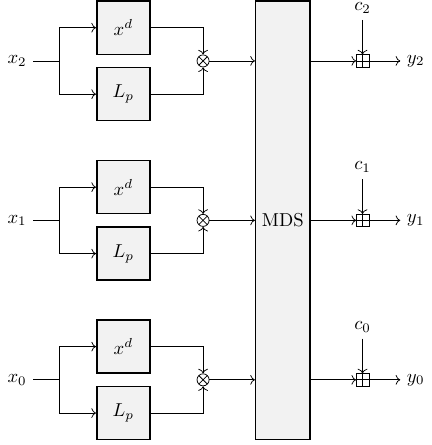
Figure 2: The round function of Grendel over F n regards its nonlinear layer, which is defined as S ( x 0 , x 1 , . . . , x n − 1 ) = S ( x 0 ) || S ( x 1 ) || · · · || S ( x n − 1 ) ,